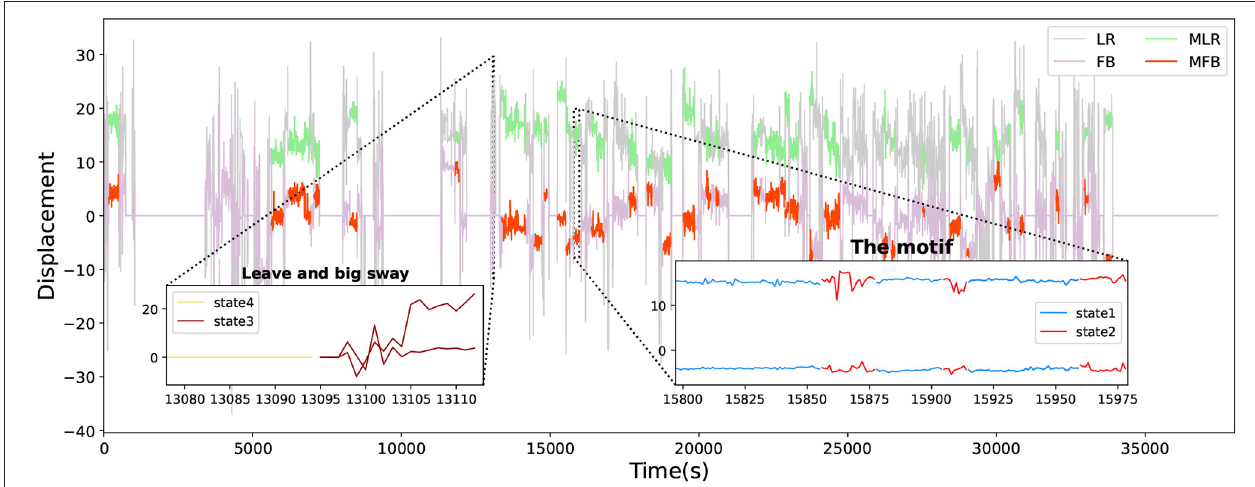
FIGURE 2 | The common motif. We used MASA to extract the most common motif from sitting behavior. LR, the change of COP in left and right; FB, the change of COP in forward and backward; MLR, the change of COP in left and right during the motif; MFB, the change of COP in forward and backward during the motif.